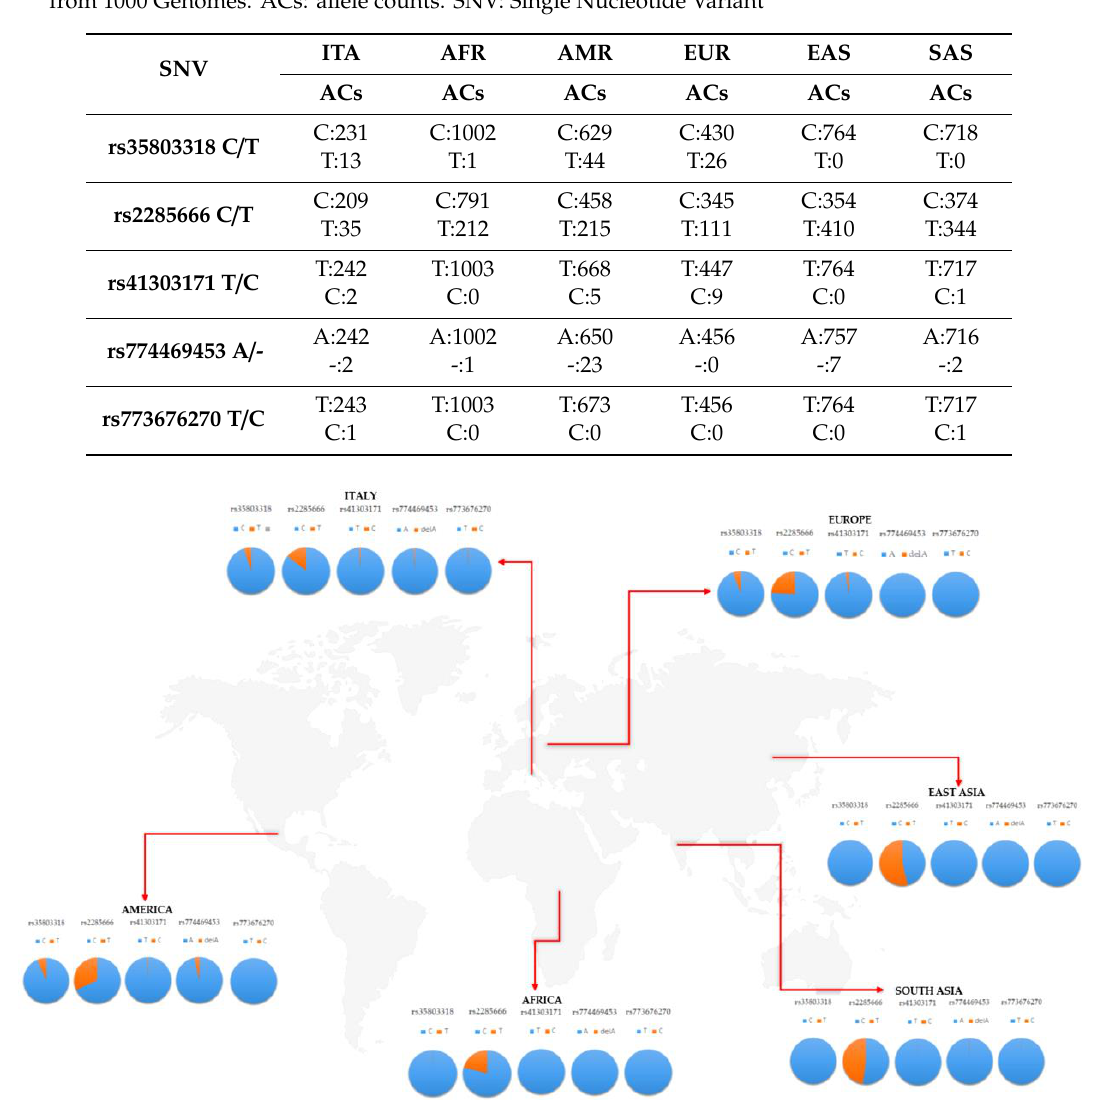
Figure 2. Frequency distribution of the five single nucleotide variants (SNVs) in the Italian cohort with respect to worldwide populations.